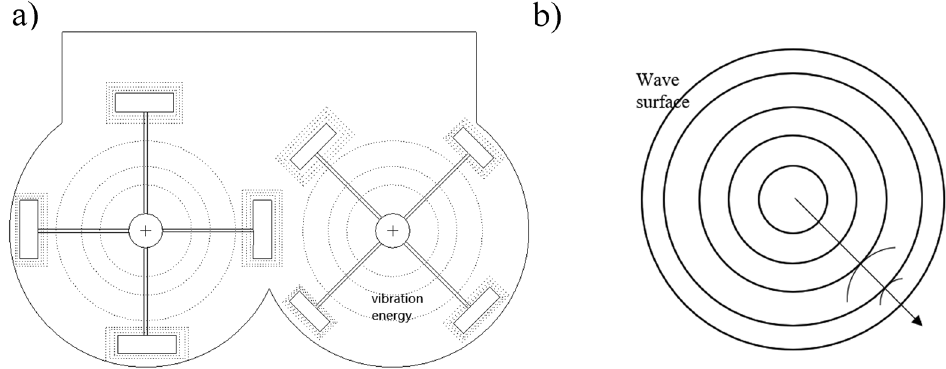
Figure 1: Schematic diagram of vibration energy transmission of double horizontal shaft vibration mixer: ( a ) distribution diagram of vibration and ( b ) vibration wave surface energy propagation.